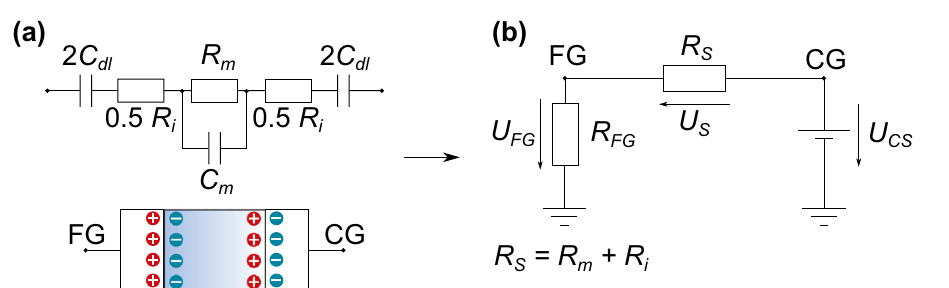
Figure 6. Equivalent circuit of ( a ) two electrodes in contact with a liquid electrolyte 25 and ( b ) of the sensing area. C dl : Capacitance of the electrochemical-double layer (EDL), R i : Resistor of the EDL, R m : Resistor of the electrolyte,